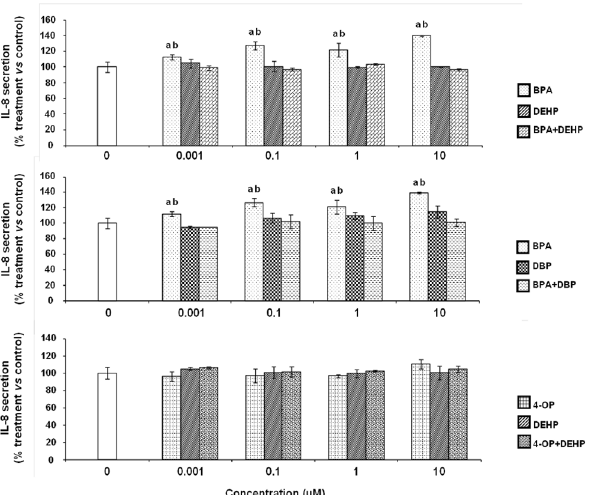
Fig 4. Effect of EDCs alone and in combination on the secretion of IL-8 by differentiated THP-1 cells. Differentiated THP-1 cells were exposed to different concentrations of BPA, DEHP, DBP, 4-OP or a combination of both for 24 hours. Culture medium was replaced by fresh medium containing 10 ng/mL of LPS for a subsequent 24 hours of incubation. IL-8 concentrations were determined using a sandwich ELISA test. Values are means ± SD (N = 3). Each experiment has been performed three times and in triplicate. a: vs control (Tukey ’ s test, p < 0.05); b: vs combination (One-way ANOVA, Tukey post test, p < 0.05).